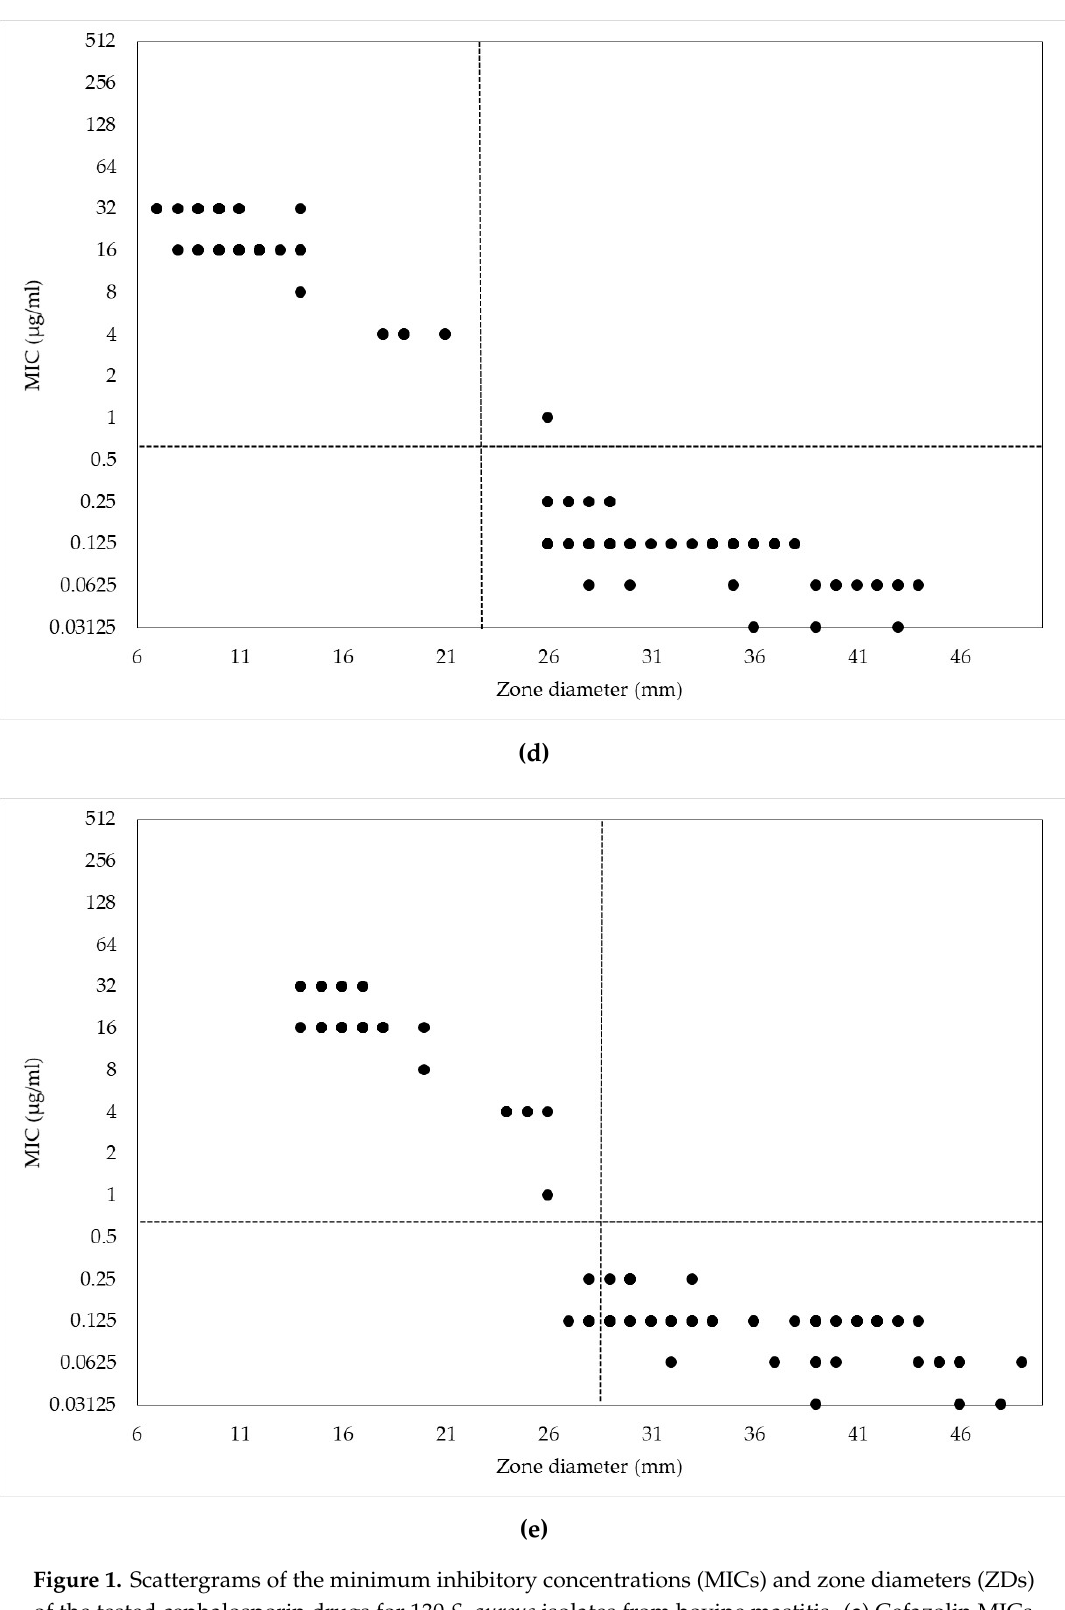
Figure 1. Scattergrams of the minimum inhibitory concentrations (MICs) and zone diameters (ZDs) of the tested cephalosporin drugs for 130 S. aureus isolates from bovine mastitis. ( a ) Cefazolin MICs versus CEZ30 ZDs; ( b ) Cefapirin MICs versus CEP10 ZDs; ( c ) Cefapirin MICs versus CEP30 ZDs; ( d ) Cefalonium MICs versus CNM10 ZDs; ( e ) Cefalonium MICs versus CNM30 ZDs. The dotted lines mean the ECVs established in this study. Each marker may include several strains.